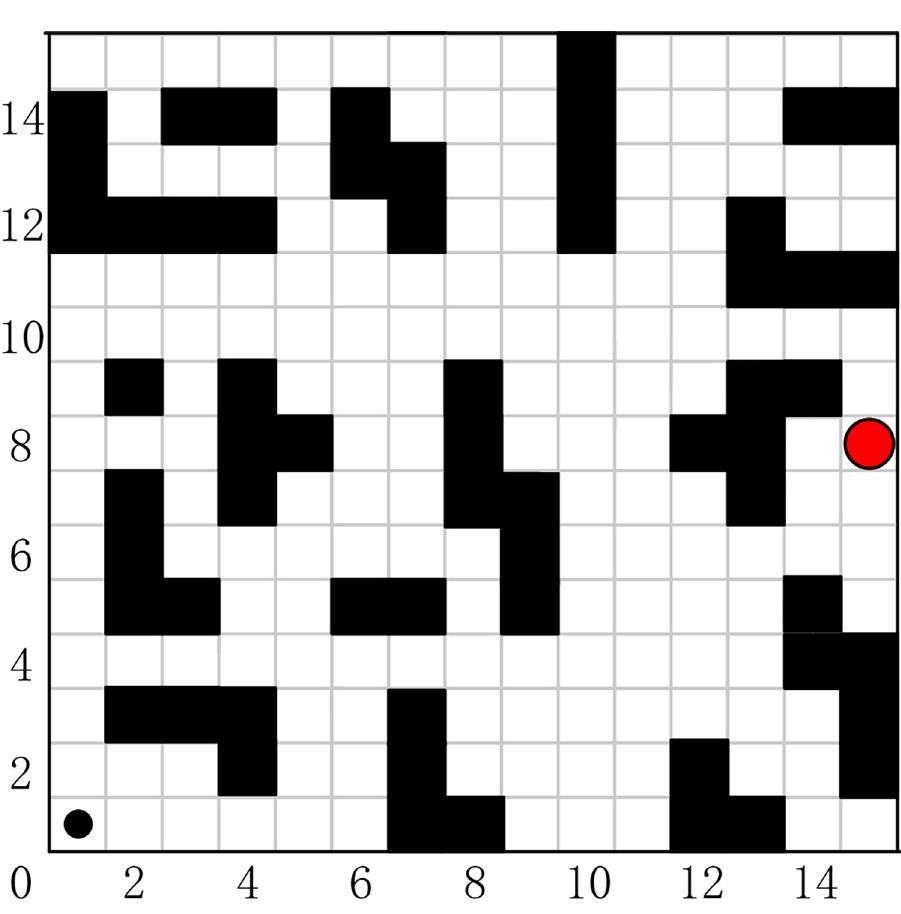
Fig 3. The classical grid